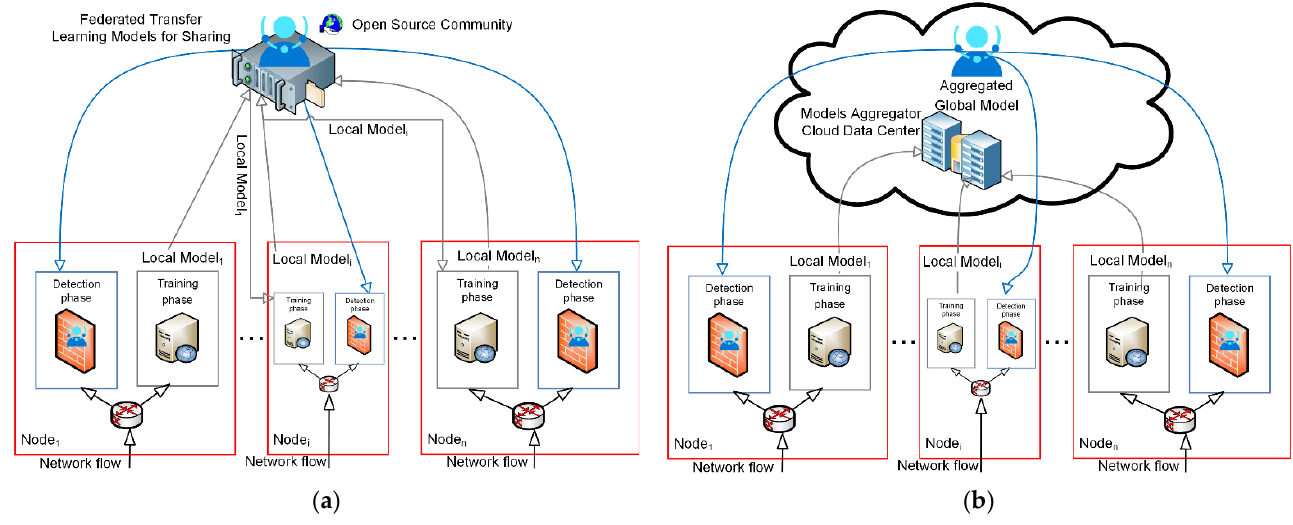
Figure 1. Network flow anomaly detection: ( a ) federated transfer learning; ( b ) federated learning.